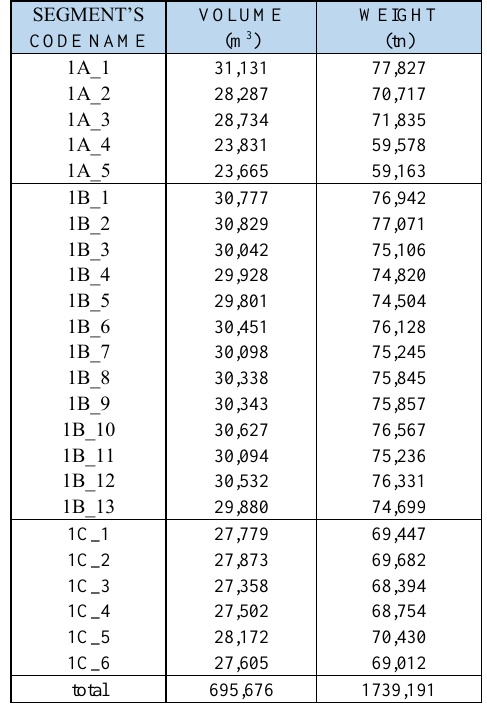
Table 1: Volume and weight of each rock